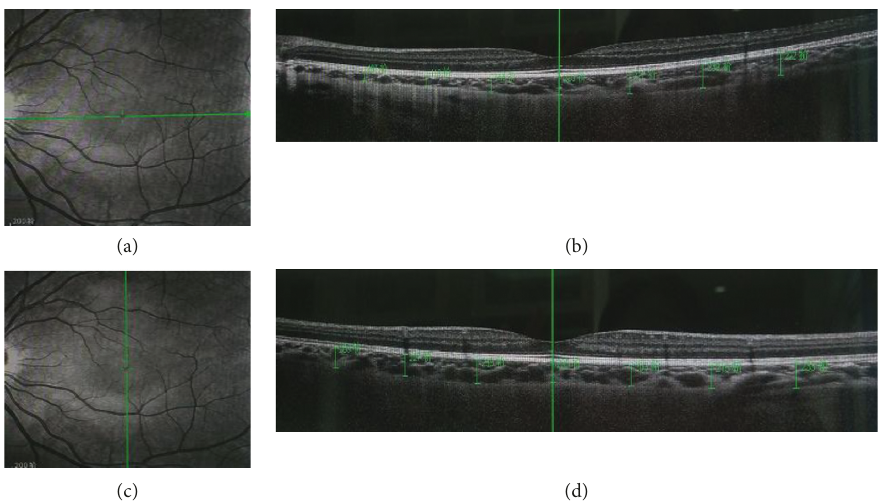
Figure 1: Choroidal scans and thickness measurements (a, b) horizontally and (c, d) vertically on